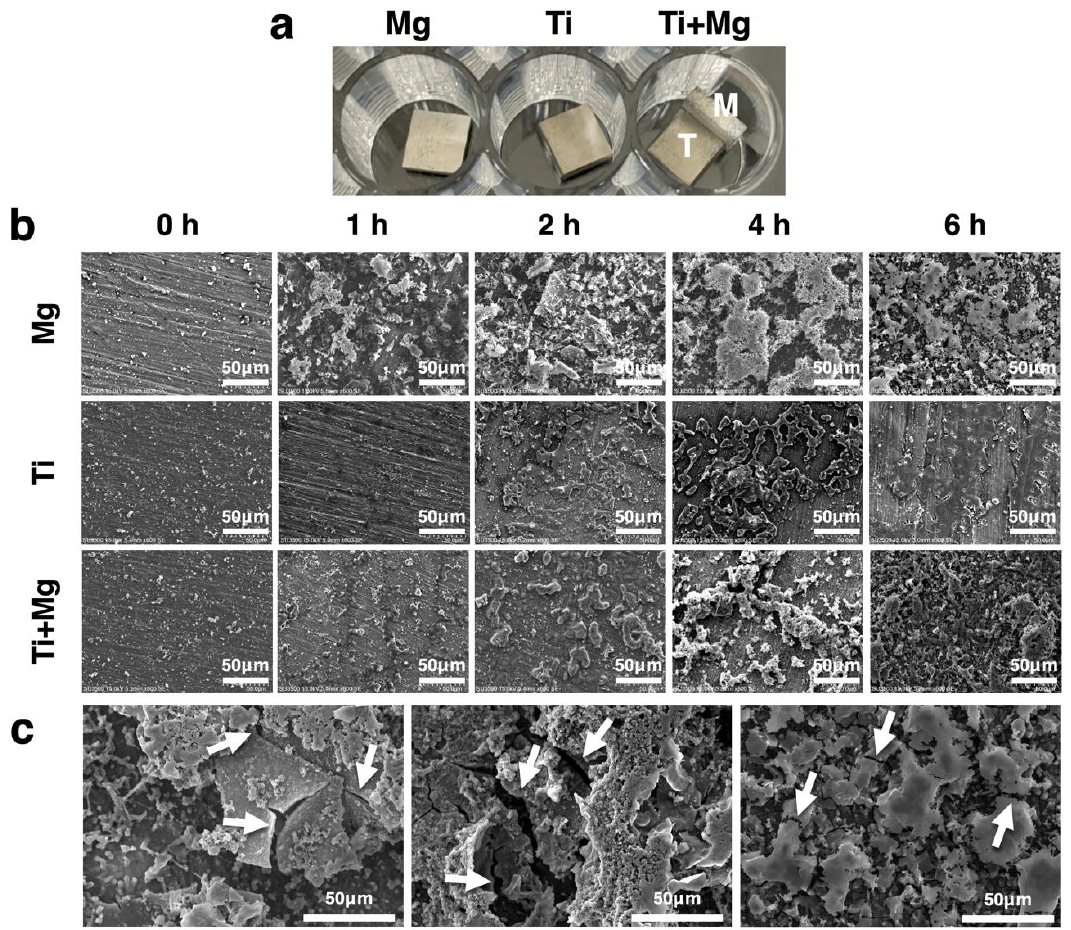
Figure 4. ( a ) Material configuration of Mg, Ti, and Ti +Mg groups for the culture of DH5-alpha E. coli culture. ( b ) SEM images of the surface of Mg group, Ti group, and Ti +Mg group at 0, 1, 2, 4, and 6 h of incubation. ( c ) The disrupted biofilms and the crack of Mg surface at six hours of incubation (indicated by arrow).